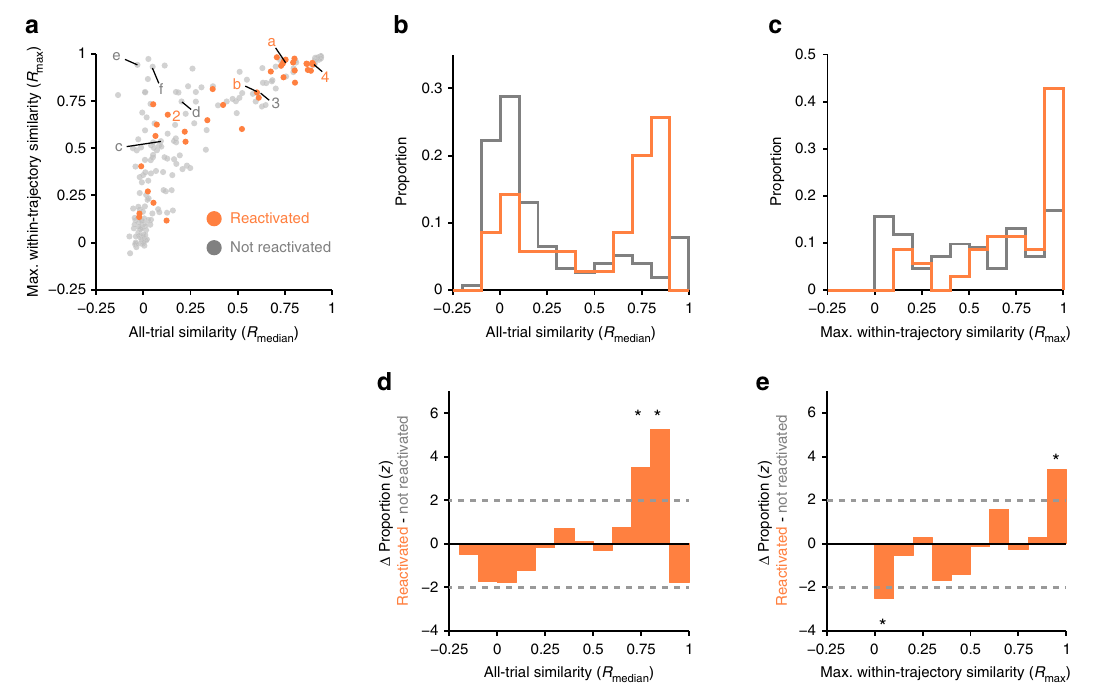
Fig. 5 SWR reactivated path-preferring PFC cells show higher activity similarity across different trajectories. a Scatter of R max and R median for SWR reactivated (orange, N = 35) and non-reactivated ( N = 161, gray) PFC cells. Cells from Figs. 1 (cells 2 and 4) and Fig. 4a (cells a-f) are labeled. b Distribution of R median (from a ). Kolmogorov – Smirnov test: *** p < 10 − 3 . c Distribution of R max (from a ). Kolmogorov – Smirnov test: *** p < 10 − 3 . d Difference in the R median distributions between path SWR reactivated and not reactivated PFC cells normalized using a permutation test (see Methods section). e Difference in the R max distributions between path SWR reactivated and not reactivated PFC cells normalized using a permutation test (see Methods section). Dotted lines indicate ±2